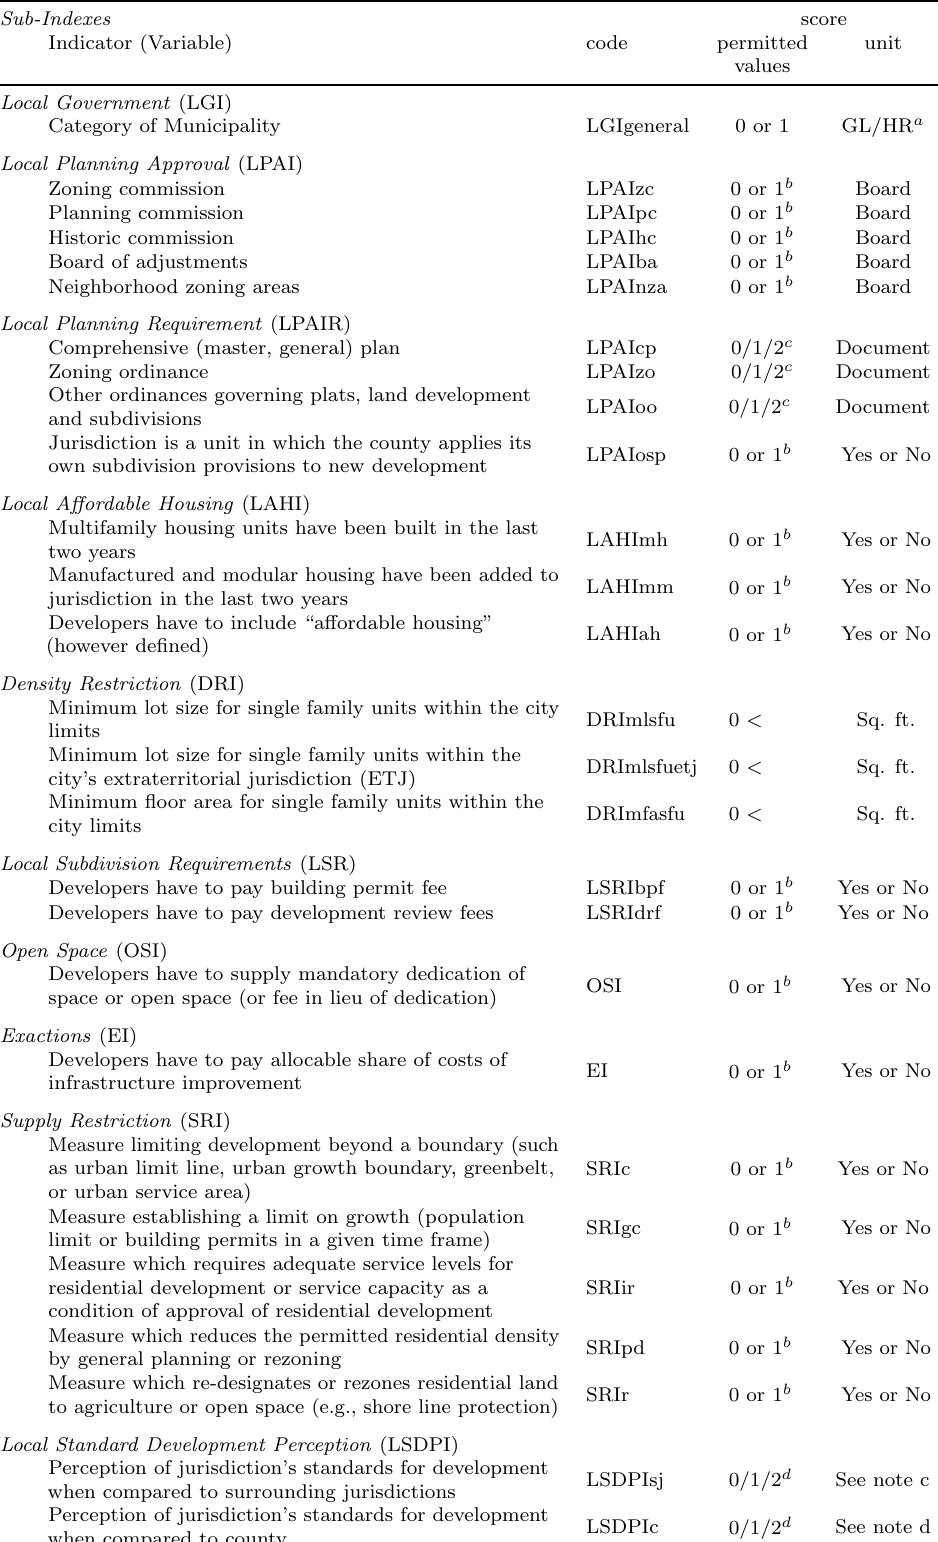
Table 1: Framework for the LURE